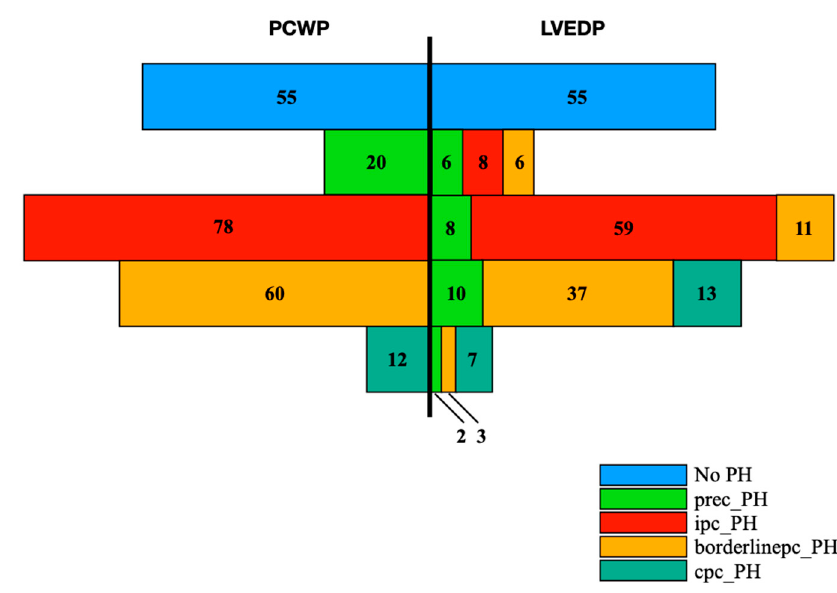
Figure 2. Categorization of the entire patient cohort ( n = 225) into the respective PH subgroups according to PCWP or LVEDP. The left side shows the subgroups according to PCWP and the right side the respective re-categorization according to LVEDP. No PH: No pulmonary hypertension; Prec-PH: pre-capillary pulmonary hypertension; Ipc-PH: isolated post-capillary pulmonary hypertension; Borderlinepc-PH: borderline post-capillary pulmonary hypertension; Cpc-PH: combined post- and pre-capillary pulmonary hypertension.